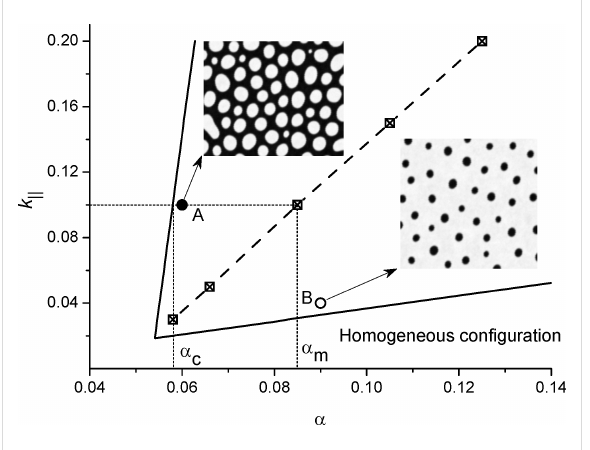
Figure 4: Stability diagram k ∥ ( α ) at ε = 4 and typical patterns in differ- ent domains: separated adsorbate islands for α = 0.06 (up inset) and k ∥ = 0.1 and separated holes in adsorbate matrix for α = 0.09, k ∥ = 0.04 (bottom inset).